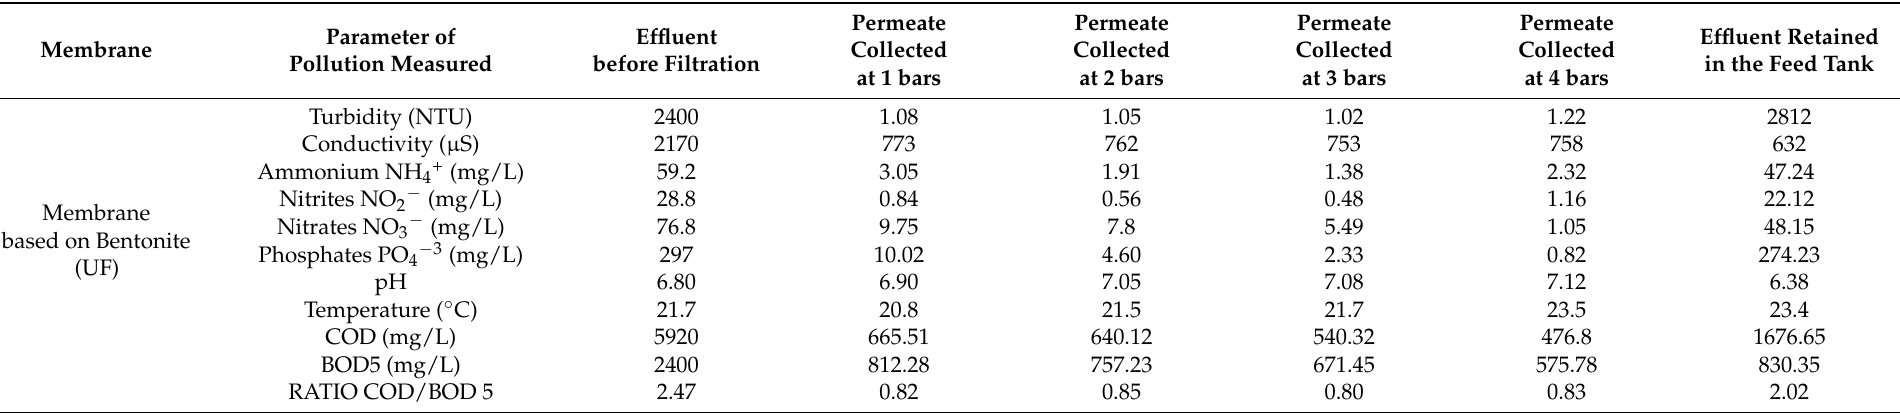
Table 4. Results of the physicochemical- pollution parameters measured on the studied effluent using membrane based on bentonite (UF).